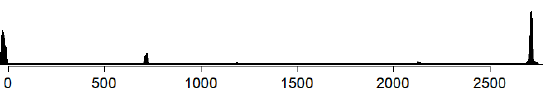
Figure 6. Histogram along y -axis